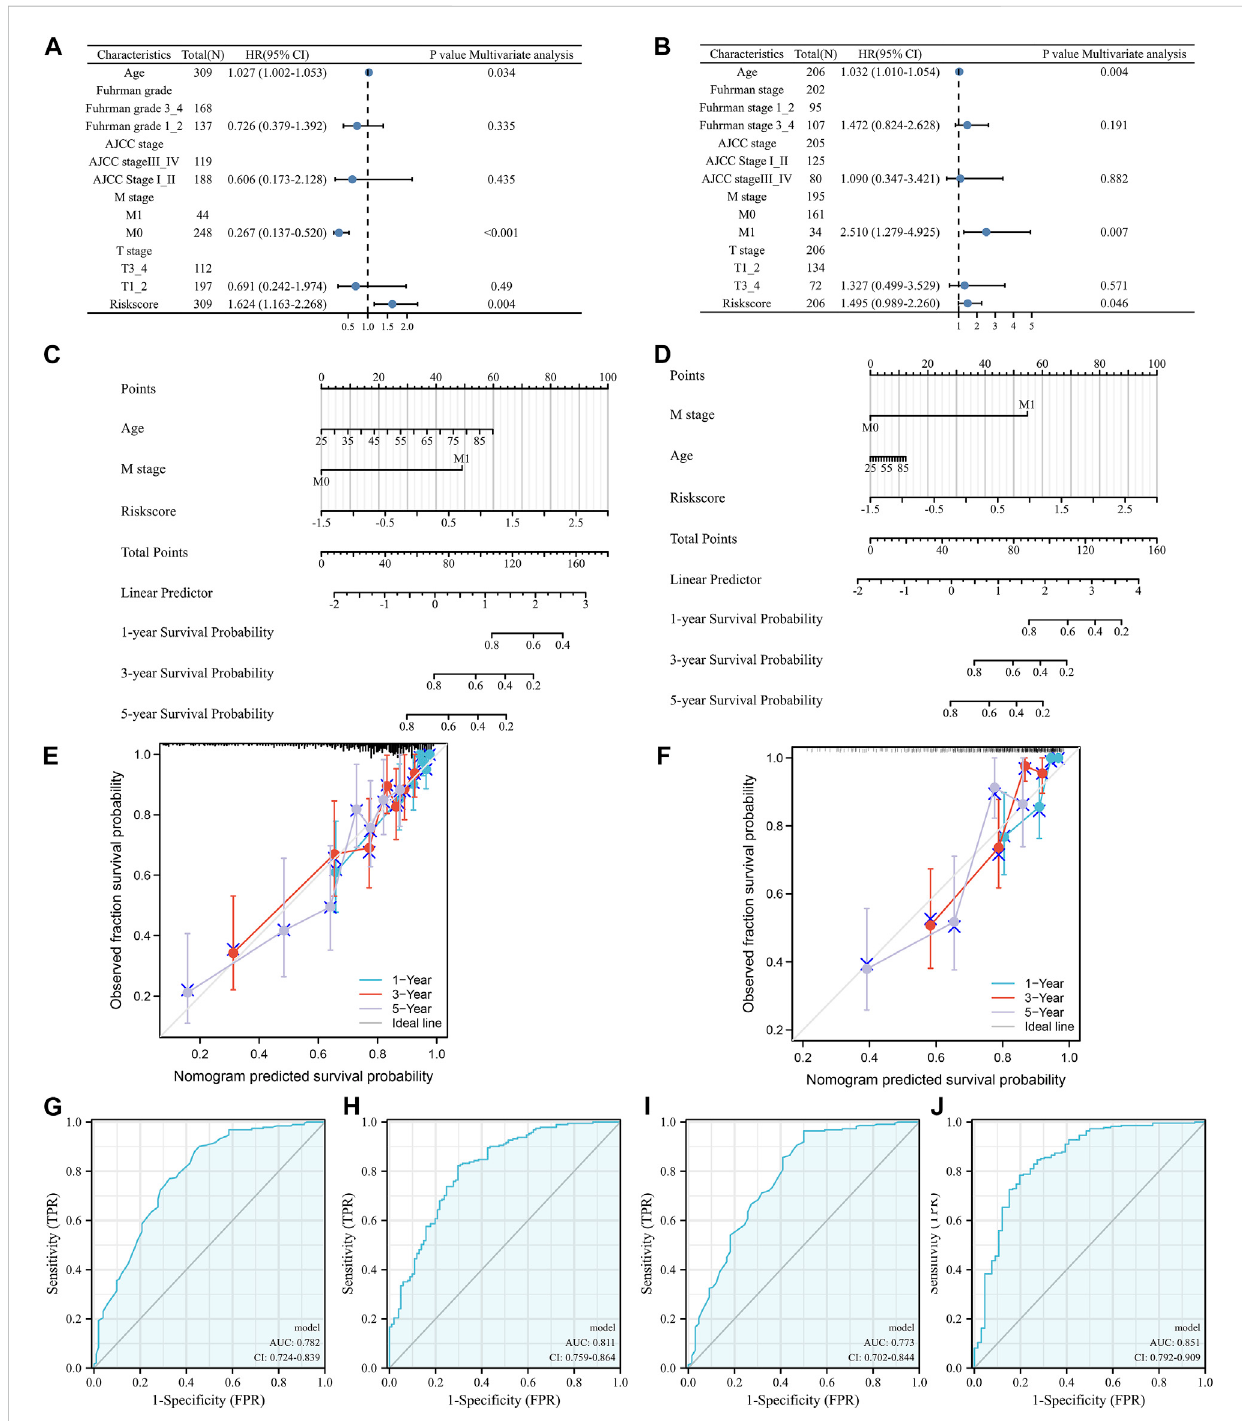
FIGURE 4 Validationoftheindependentprognosticvalueoftheindex:multivariableCoxregressionmodelinTCGAtraininggroup (A) andTCGAtestgroup (B) , nomograms of TCGA training group (C) and TCGA test group (D) , calibration plots of TCGA training nomogram (E) and TCGA test nomogram (F) , multiparameter ROC analysis without (G) /with (H) the index in TCGA training nomogram, multiparameter ROC analysis without (I) /with (J) the index in TCGA test nomogram, N: lymph node metastasis; M: distant metastasis; AJCC: American Joint Committee on